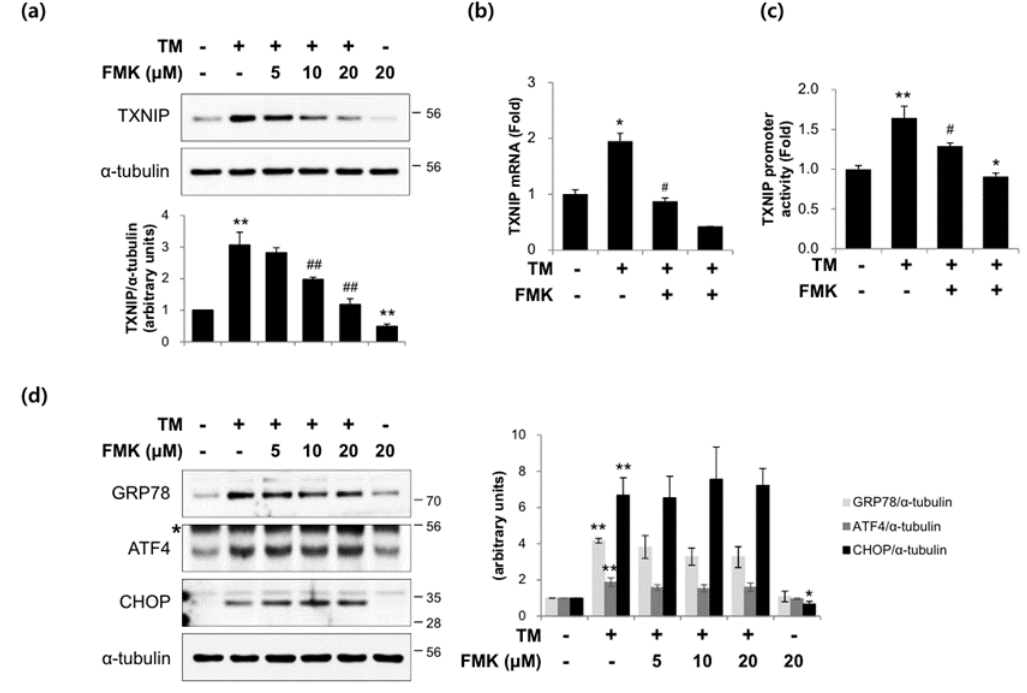
Figure 7. FMK pretreatment reduced tunicamycin-induced TXNIP expression. ( a ) INS-1 cells were pretreated with FMK (5, 10 or 20 μM) for 1 h, and then treated with tunicamycin (TM, 10 μM) for 9 h. Protein levels were measured by immunoblotting. The graph shows the densitometric quantification of western blot bands. Results are expressed as means ± SDs and are representative of three independent experiments. ** p < 0.01 vs. non-treated controls, ## p < 0.05 vs. HG-treated cells. ( b ) INS-1 cells were pretreated with FMK (2 0 μM) for 1 h, and then incubated with TM for 9 h. mRNA levels of TXNIP were measured by qRT-PCR. Relative expression levels were normalized versus GAPDH. Results are expressed as the means ± SDs of three independent experiments. * p < 0.05 and ** p < 0.01 vs. non-treated controls, # p < 0.05 vs. TM-treated cells. ( c ) INS-1 cells were transfected with TXNIP-luc for 24 h, pretreated with FMK (20 μM) for 1 h, and then treated with TM for 9 h. Luciferase activities in cell lysates were assessed using a dual luciferase reporter assay kit with a Glomax 20/20 luminometer. Transfection efficiencies were normalized versus Renilla luciferase activity derived from a pRL-tk construct. Results are expressed as the means ± SDs of three independent experiments. * p < 0.05 and ** p < 0.01 vs. non-treated controls, # p < 0.05 vs. TM-treated cells. ( d ) INS-1 cells were pretreated with FMK (5, 10 or 20 μM) for 1 h, and then treated with TM for 9 h. Protein levels were measured by immunoblotting. The graph shows the densitometric quantification of western blot bands. Results are expressed as means ± SDs and are representative of three independent experiments. * p < 0.05 and ** p < 0.01 vs. non-treated controls. The asterisk indicates a non-specific band.